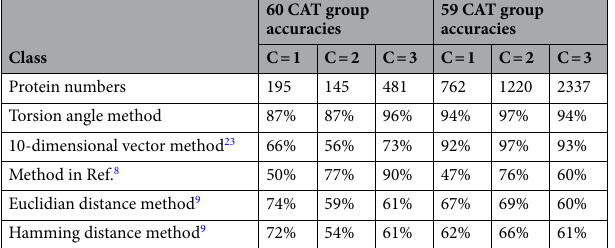
Table 1. Comparison of the accuracies of different methods for the prediction of protein structural classes. Each group is divided into alpha structure (C = 1), beta structure (C = 2) and mixed structure (C = 3)